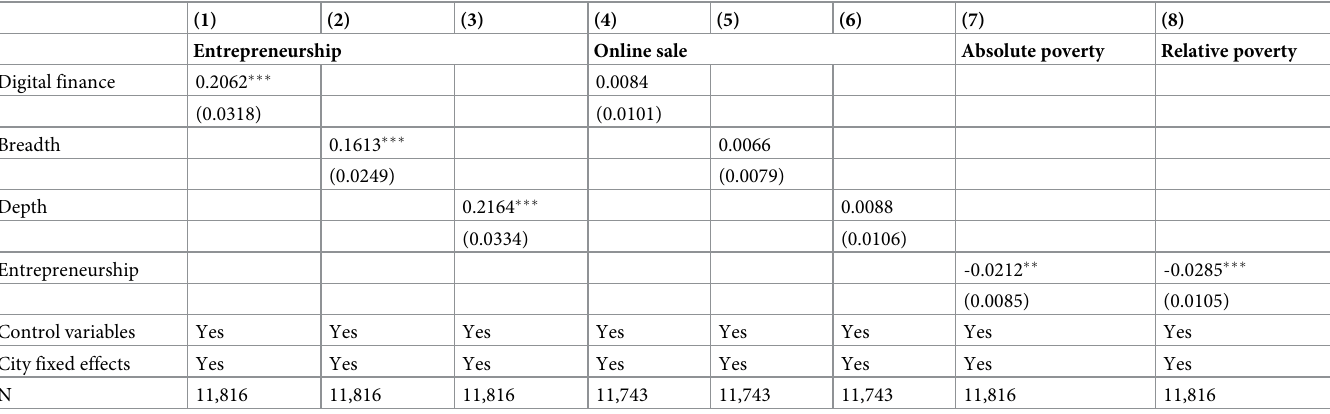
Table 12. Digital finance, entrepreneurship, and rural household